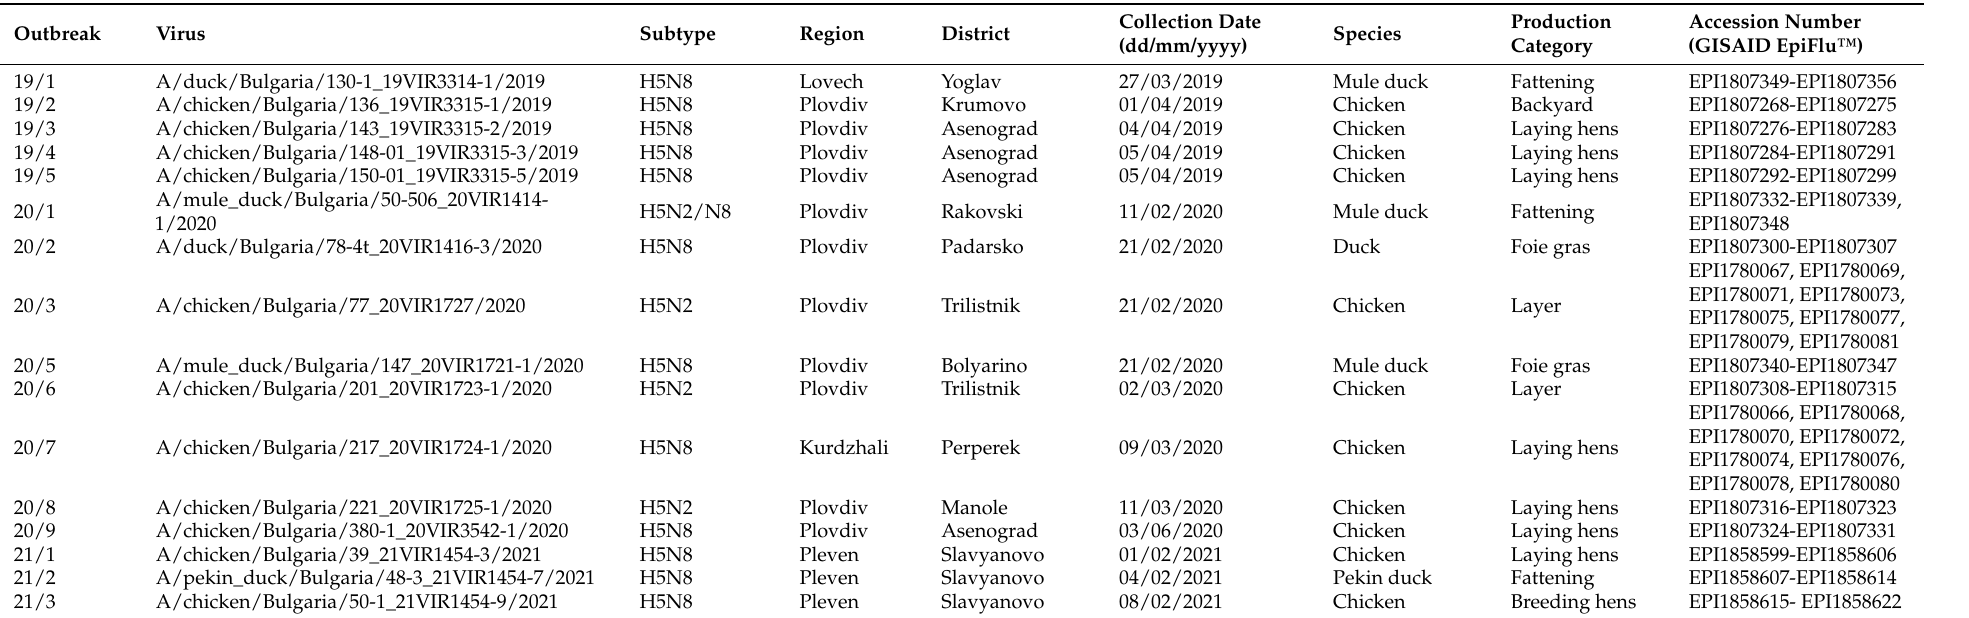
Table 1. Analyzed viruses, epidemiological information and GISAID EpiFlu™ database accession